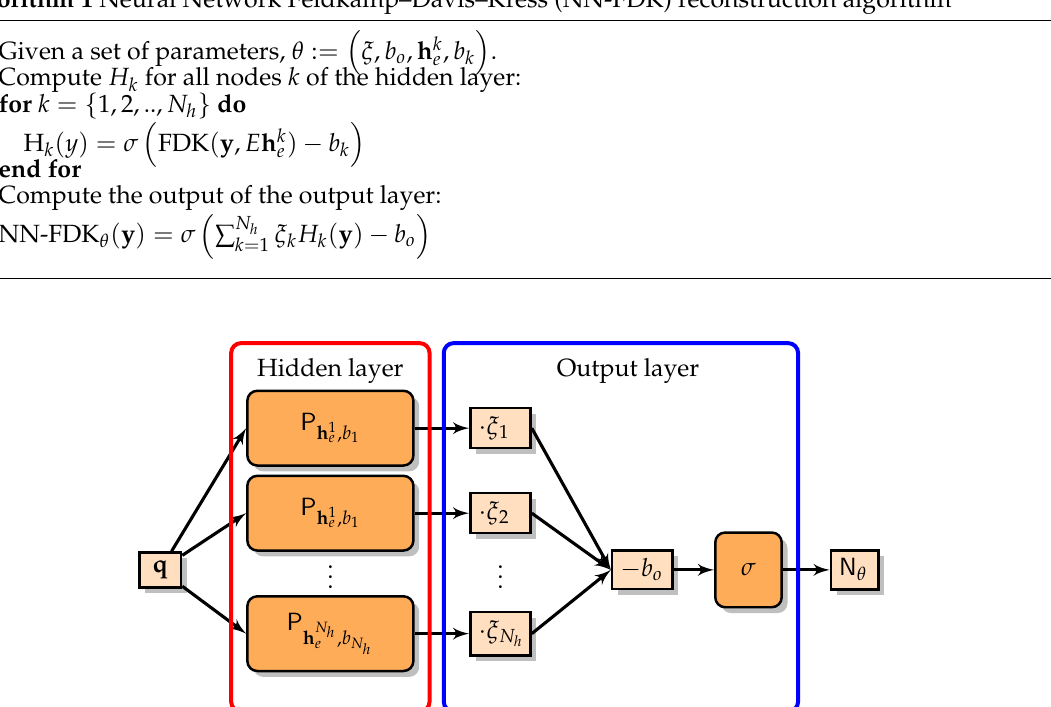
Figure 1. Schematic representation of the NN-FDK network, N θ : R N e